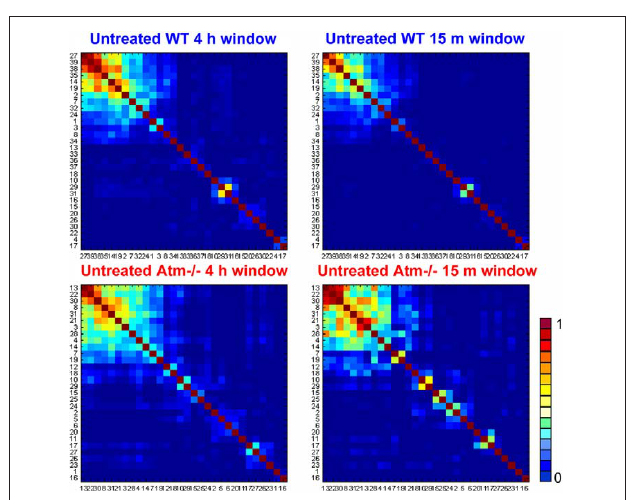
Figure 7 | Comparison between dendrogramed synchronization matrices calculated for long (4 h) and short (15 min) time windows. The 4-h synchronization matrices for WT (top) and Atm − / − (bottom) are shown on the left, and the ones for 15 min are shown on the right. The matrices for all four cases show the existence of synchronization cliques as is reflected by the detected clusters of highly synchronized neurons.